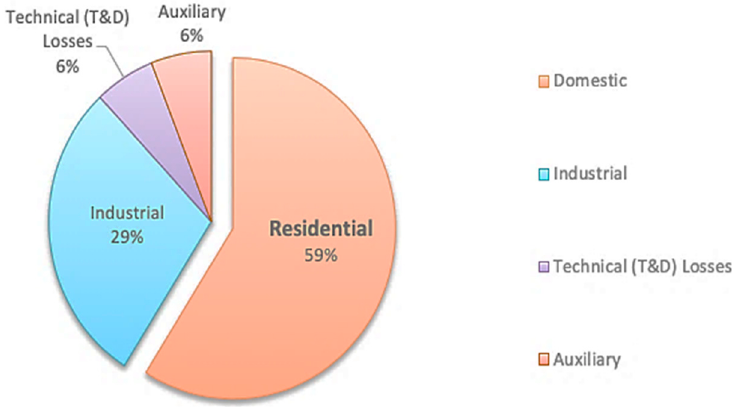
Figure 1. Sectorial percentages of power consumption for the year 2016 in Qatar [3].